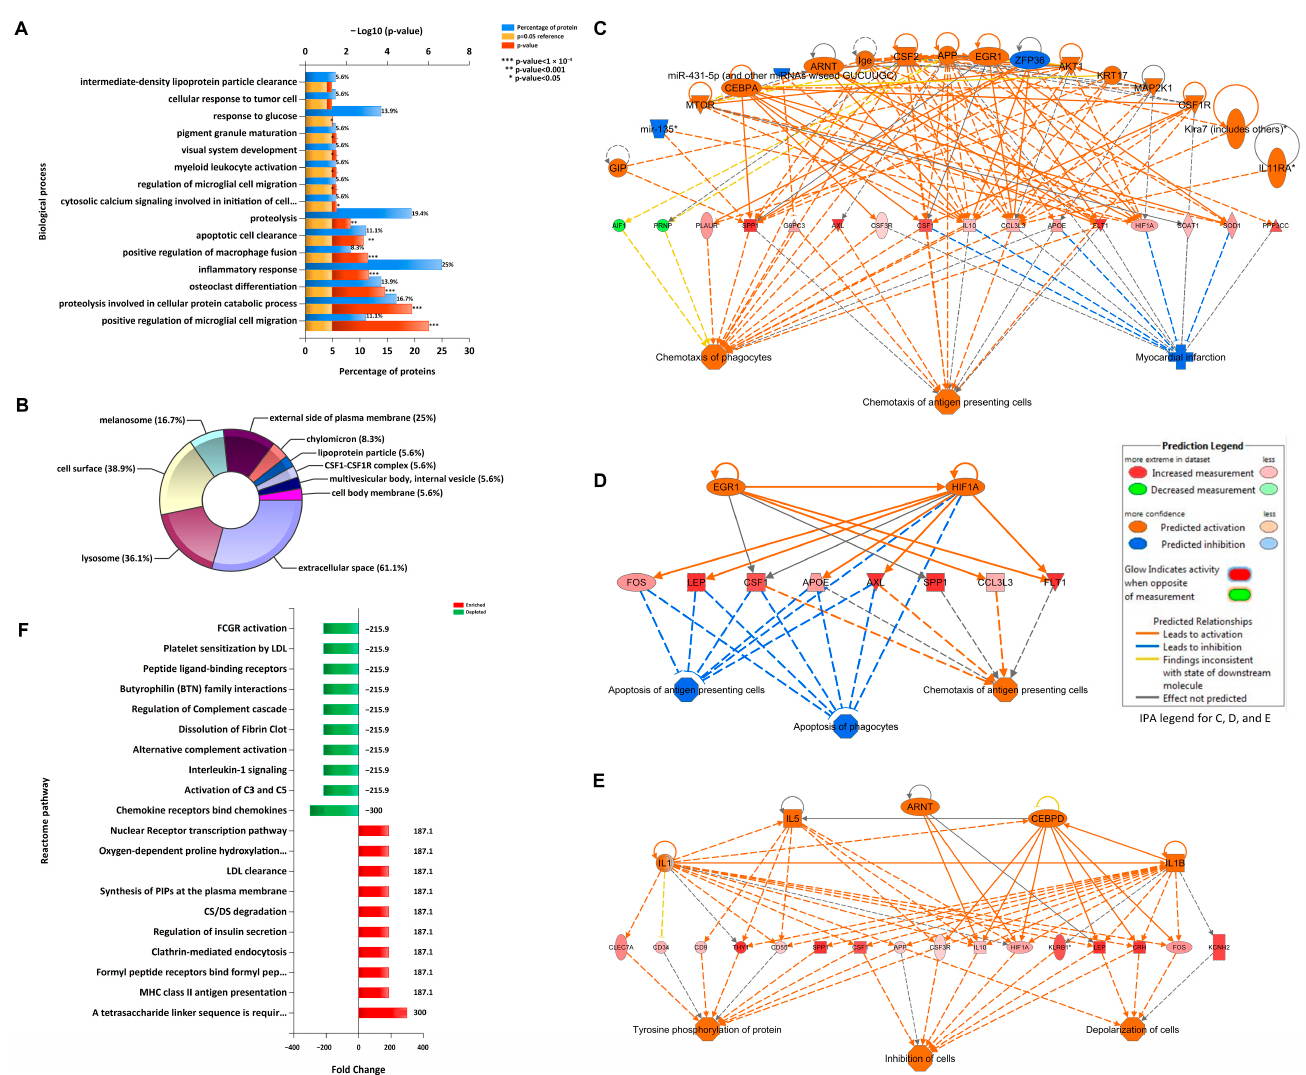
Figure 2. Pathway enrichments and regulation networks of Trem2-dependent DAM markers. ( A ) Gene ontology biological process pathway enrichment analysis of the major DAM markers. ( B ) Gene ontology cellular component enrichment analysis of the major DAM markers. ( C ) Upstream regulators and downstream chemotaxis effect of the DAM markers ( Spp1 , Axl , Csf1 , and Apoe ). ( D ) Upstream regulators and downstream anti-apoptosis effect of the DAM markers ( Csf1 , Apoe , Axl , and Spp1 ). ( E ) Upstream regulators and downstream cellular depolarization effect of the DAM markers ( Clec7a , Cd9 , Spp1 , and Csf1 ). ( F ) Fold enrichment analysis of the neurodegeneration-related modules (DAM and DAM-related